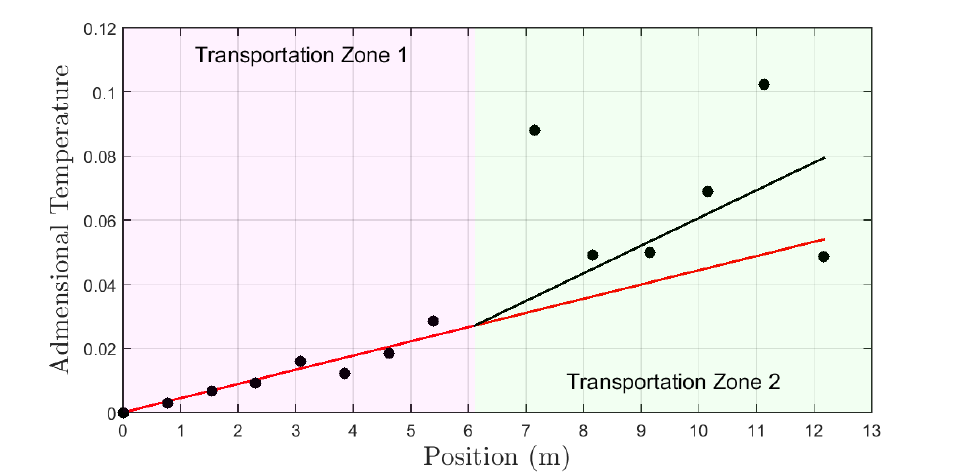
Figure 13. Dimensionless profile—experiment type